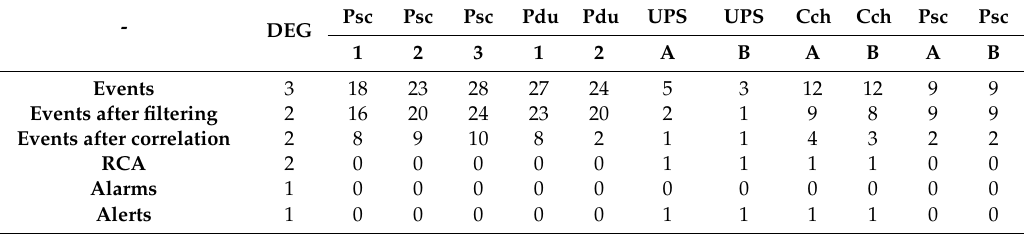
Table 4. Comparison of the alert / event number (with root cause method (RCM))—data center power supply